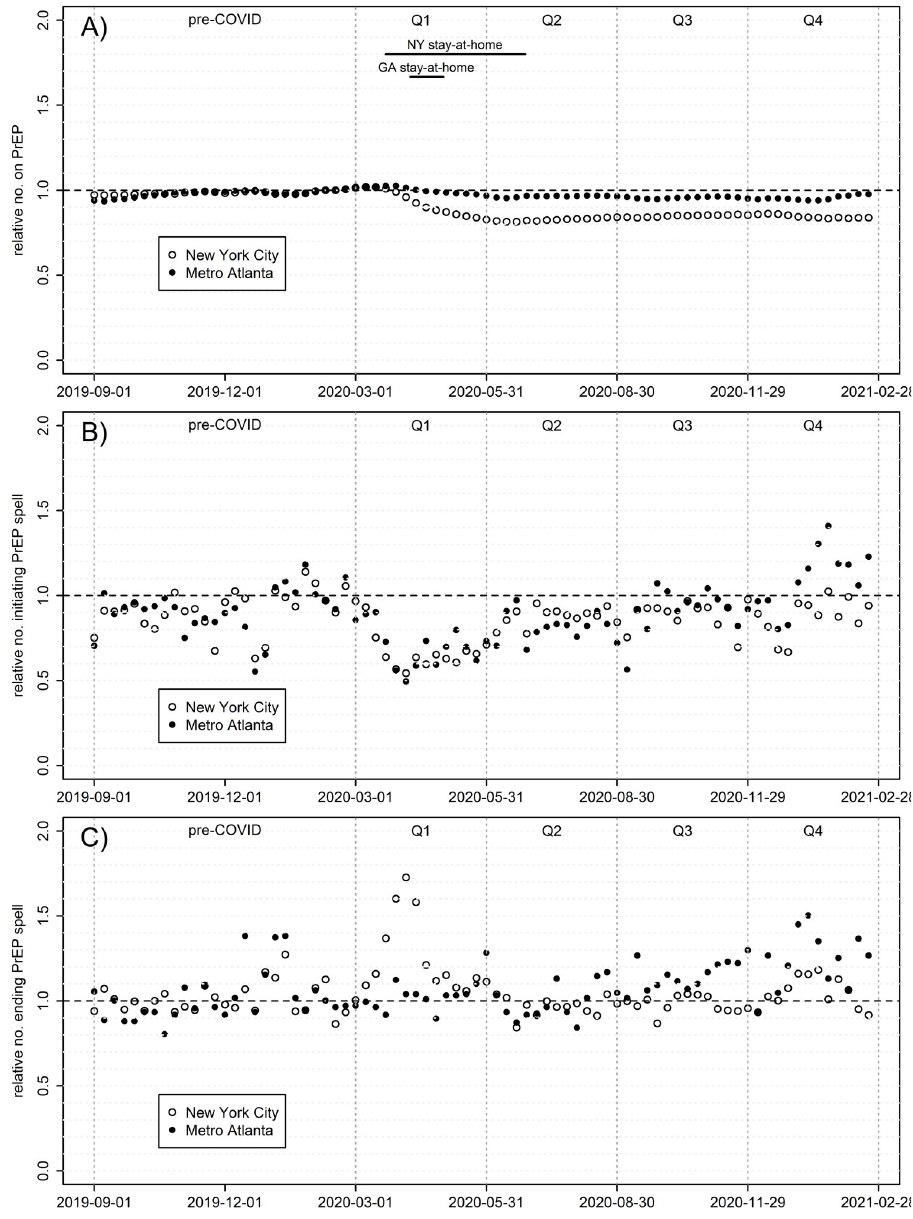
Fig 2. PrEP prescriptions among males, by week, relative to the weekly mean Feb. 2 –Feb. 29, 2020. A) Relative prevalence of ongoing prescription spells; (B) relative number initiating a new prescription spell; C) relative number terminating a prescription